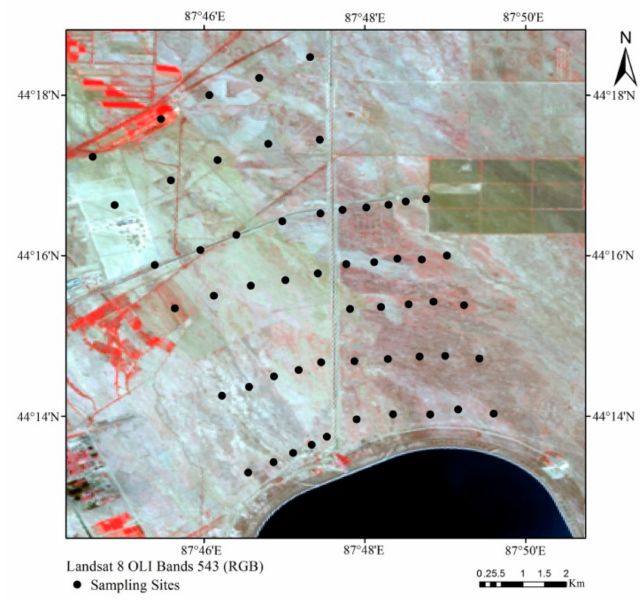
Figure 5. Distribution of soil-sampling